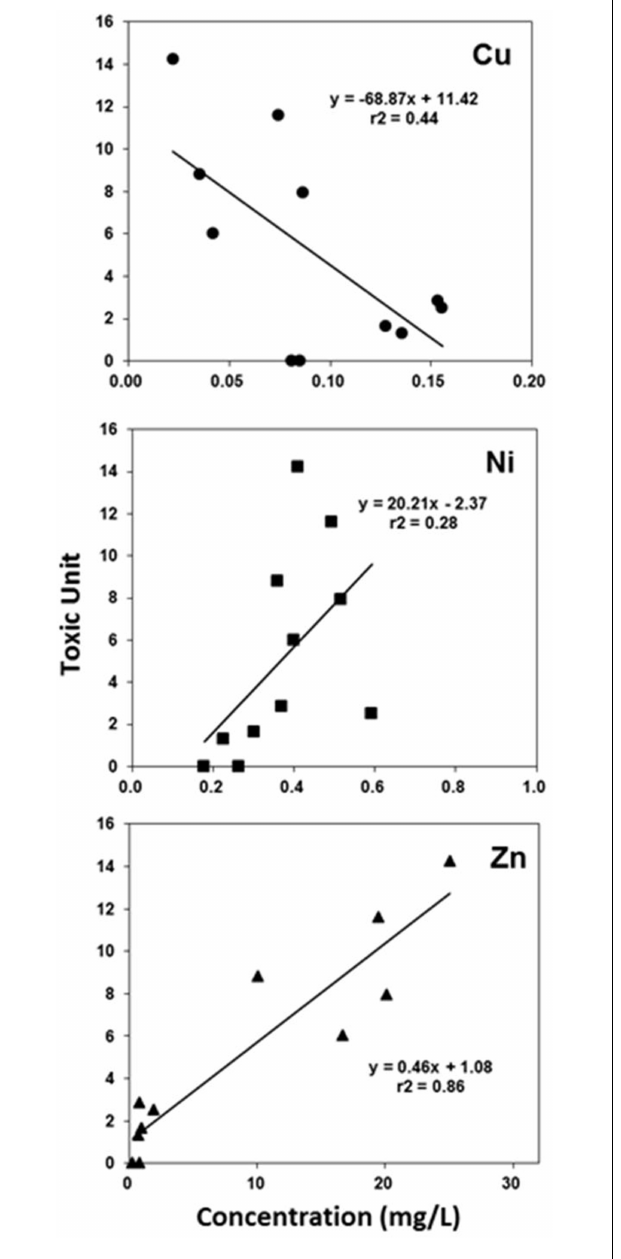
FIGURE 5 | Correlation of metal concentrations contained in the final effluent (FE) with the toxicity of final effluent based on U. pertusa